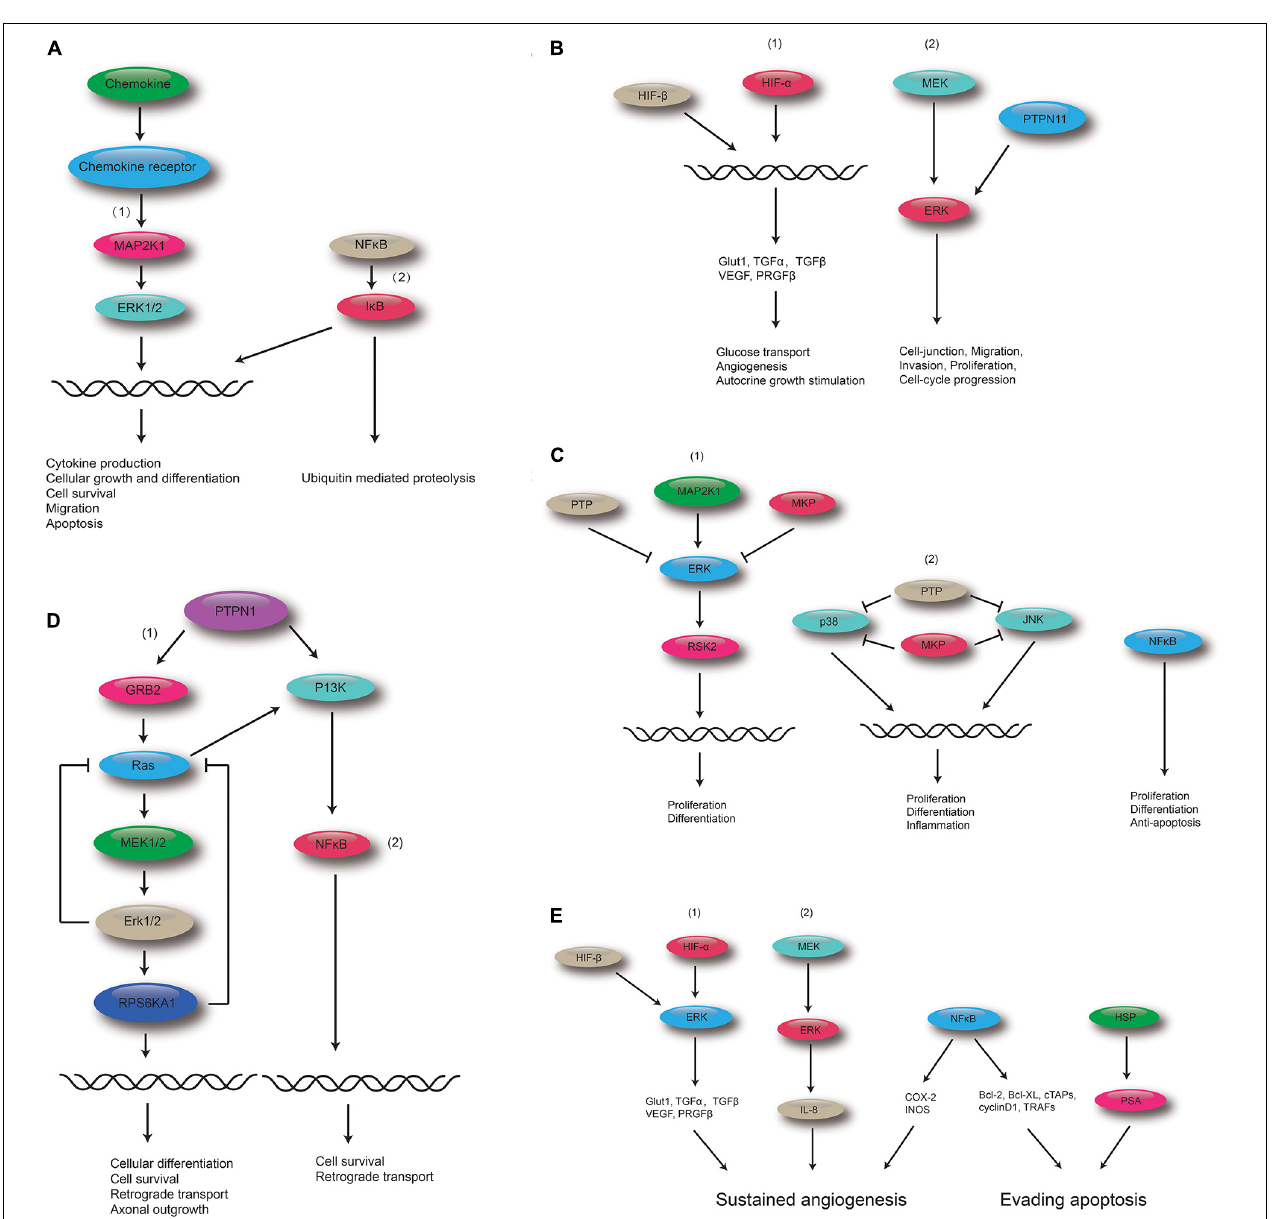
FIGURE 6 | Polydatin-targeted genes related to the top five shared KEGG pathways. (A) Polydatin-targeted genes related to the Chemokine signaling pathway: (1) MAPK signaling pathway and (2) NF-kB. (B) Polydatin-targeted genes related to Renal cell carcinoma: (1) HIF-1 signaling pathway, and (2) MAPK signaling pathway. (C) Polydatin-targeted genes related to the MAPK signaling pathway:(1) Classical MAP kinase pathway, (2) JUK and p38 MAP kinase pathway, and (3) NF κ B. (D) Polydatin-targeted genes related to the Neurotrophin signaling pathway: (1) MAPK signaling pathway, and (2) NF κ B. (E) Polydatin-targeted genes related to Pathways in cancer: (1) HIF-1 signaling pathway, (2) MAKP signaling pathway, (3) NF κ B, and (4)